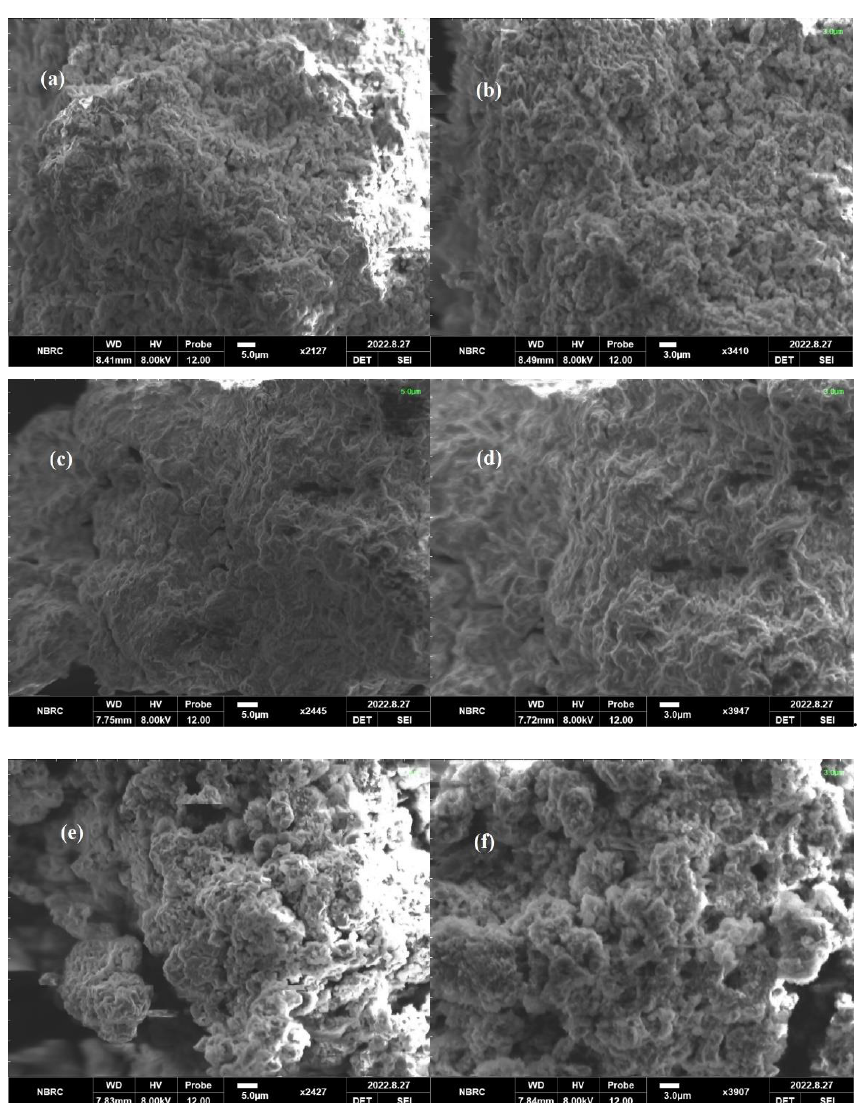
Figure 3. SEM of ( a , b ) S1, ( c , d ) S2, and ( e , f ) S3 POA/g-C 3 N 4 /ZnO composites.